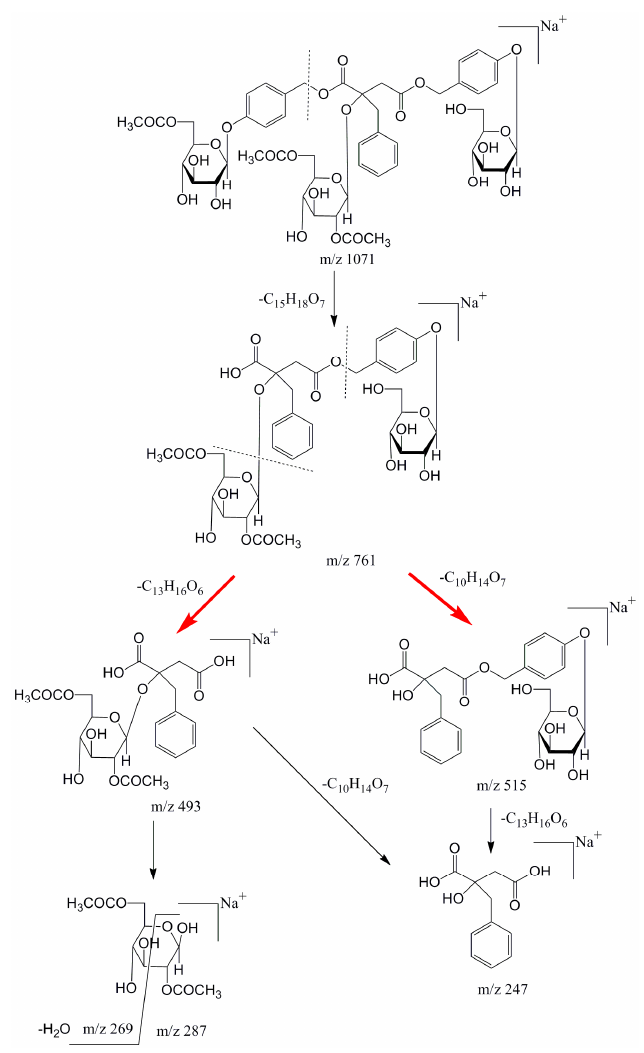
Figure 4. Proposed MS fragment pathway of compound 6 .